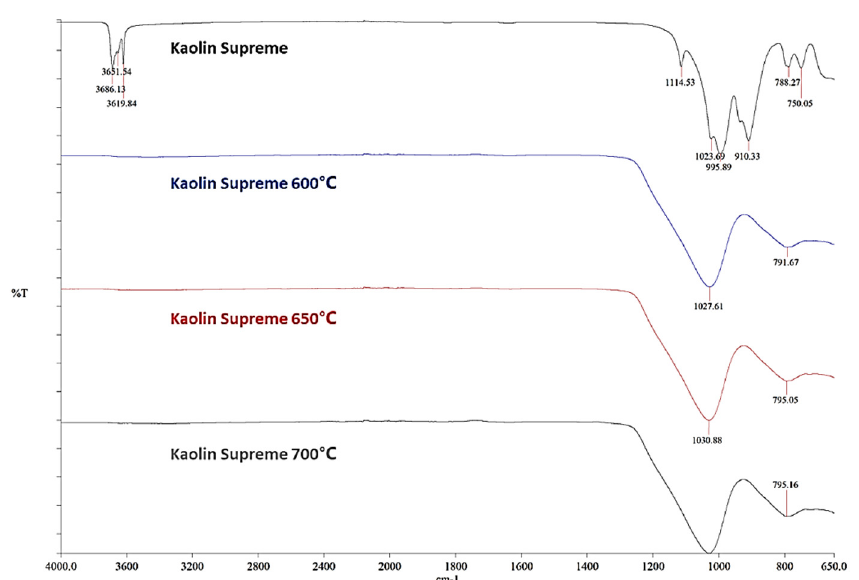
Figure 8. FTIR spectra of Kaolin Supreme and its calcined products at 600, 650 and 700 °C.